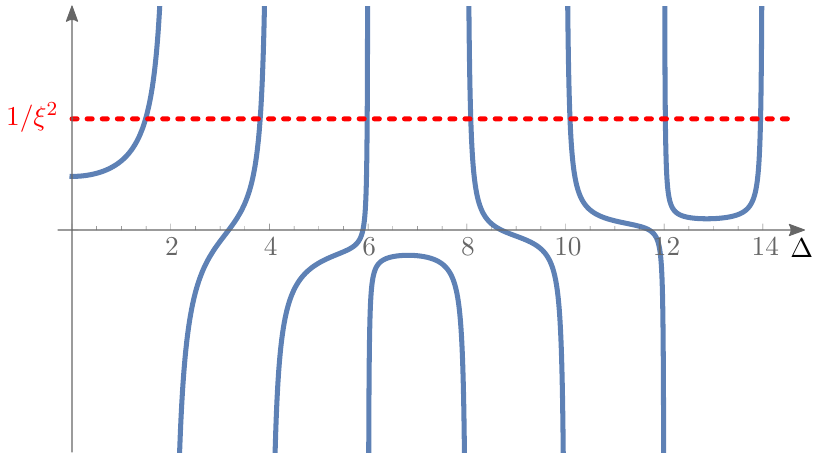
Figure 15 . The eigenvalue of the graph building operator E ((cid:1) ; 0 ; 0) in (5.22) at (cid:18) = 1. It has poles at the positive real even integers (cid:1) 0 = 2 + 2 n . The spectrum is giving by equating E ((cid:1) ; 0 ; 0) with 1 =(cid:24) 2 and is represented by the intersection with the red dashed line. The solution between the n -th and the ( n (cid:0) 1)-th poles correspond to the operator (cid:3) n tr wave function